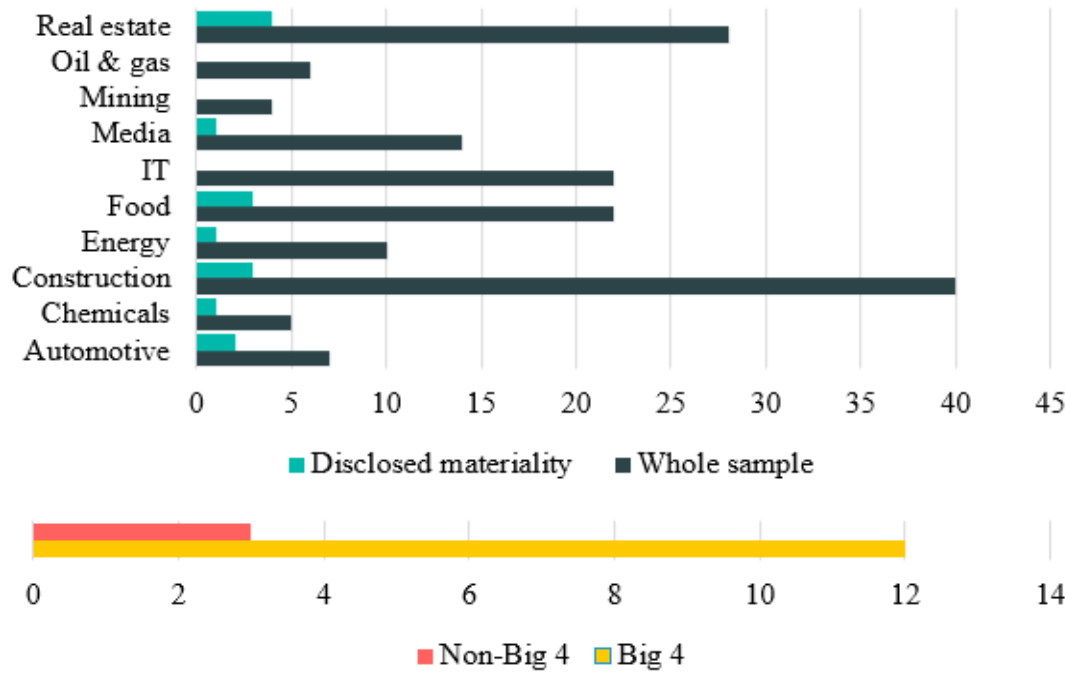
Figure 9. Companies listed on the Warsaw stock exchange for which materiality levels were disclosed by auditors—by WIG and non-Big/Big 4 auditors. Source: own elaboration based on analyzed data.